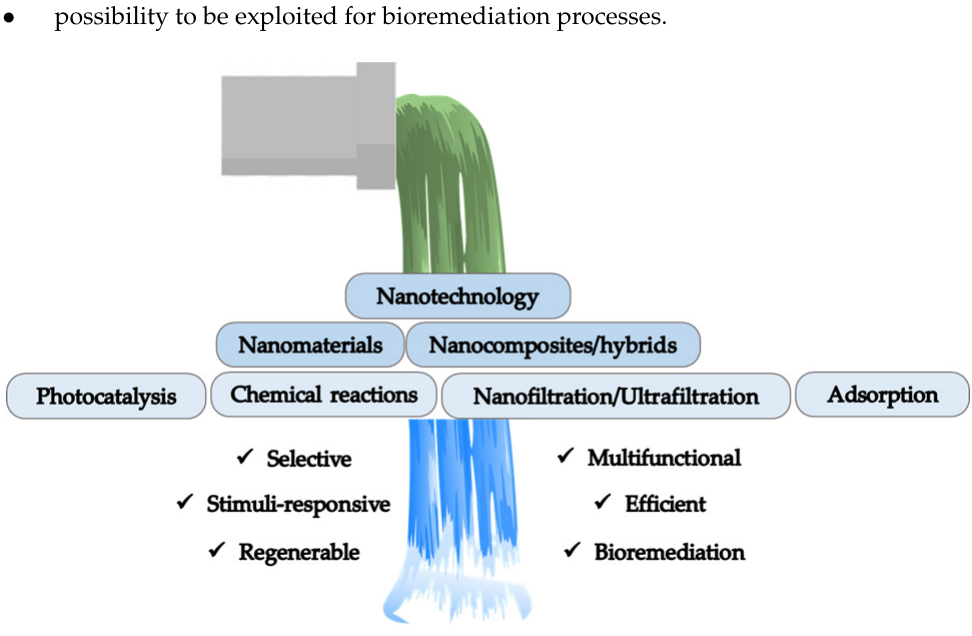
Figure 8. Advantages in the use of nanotechnology for wastewater treatment processes.